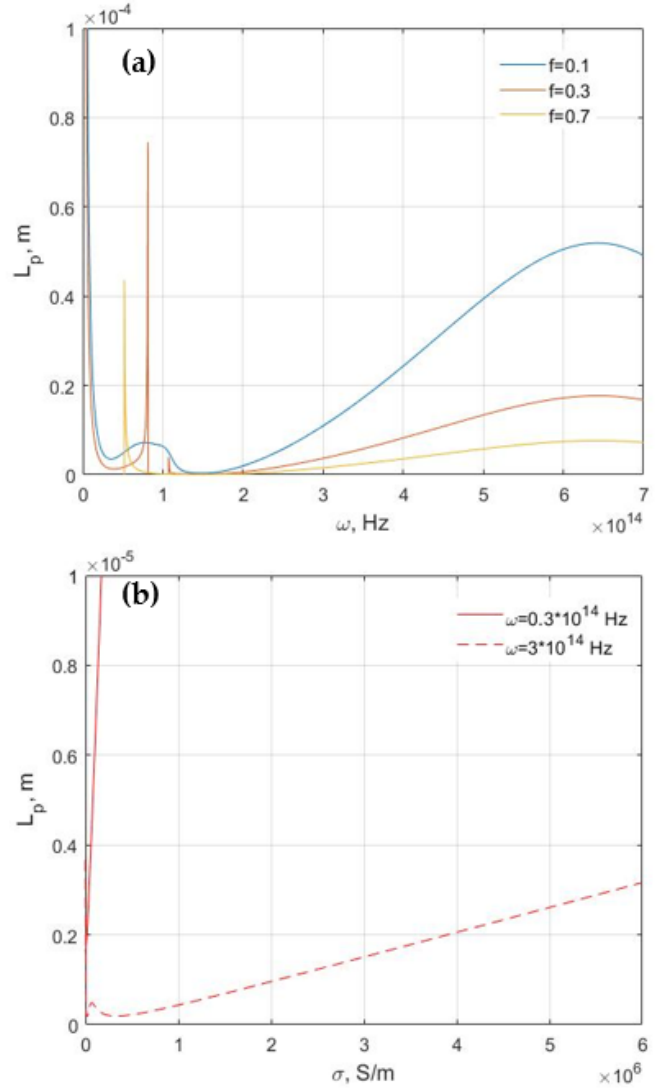
Figure 9. Dependence of propagation length versus frequency for different filling factors ( a ) and versus conductivity for f = 0.3 ( b ). ε n = 2.25, ε d = 11.8. All the presented results are obtained for the ITO inclusions.